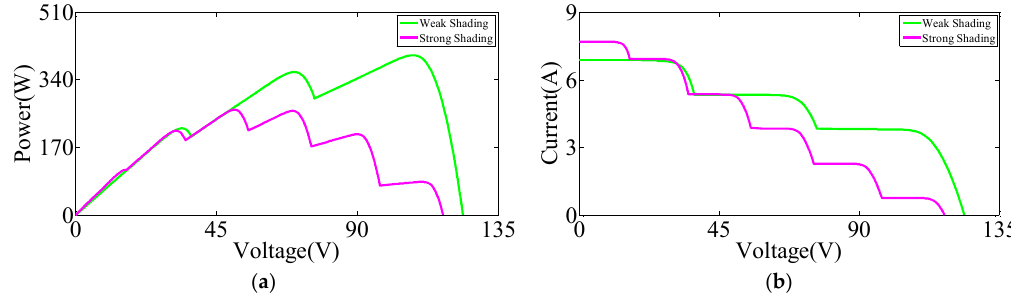
Figure 7. The output characteristics of the PV array for different shading levels ( a ) P-V curve; ( b ) I-V curve.